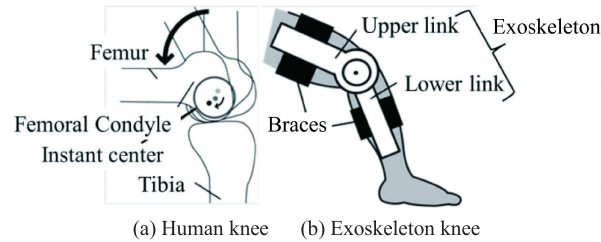
Figure 1. Misalignment between human and wearable exoskeleton.